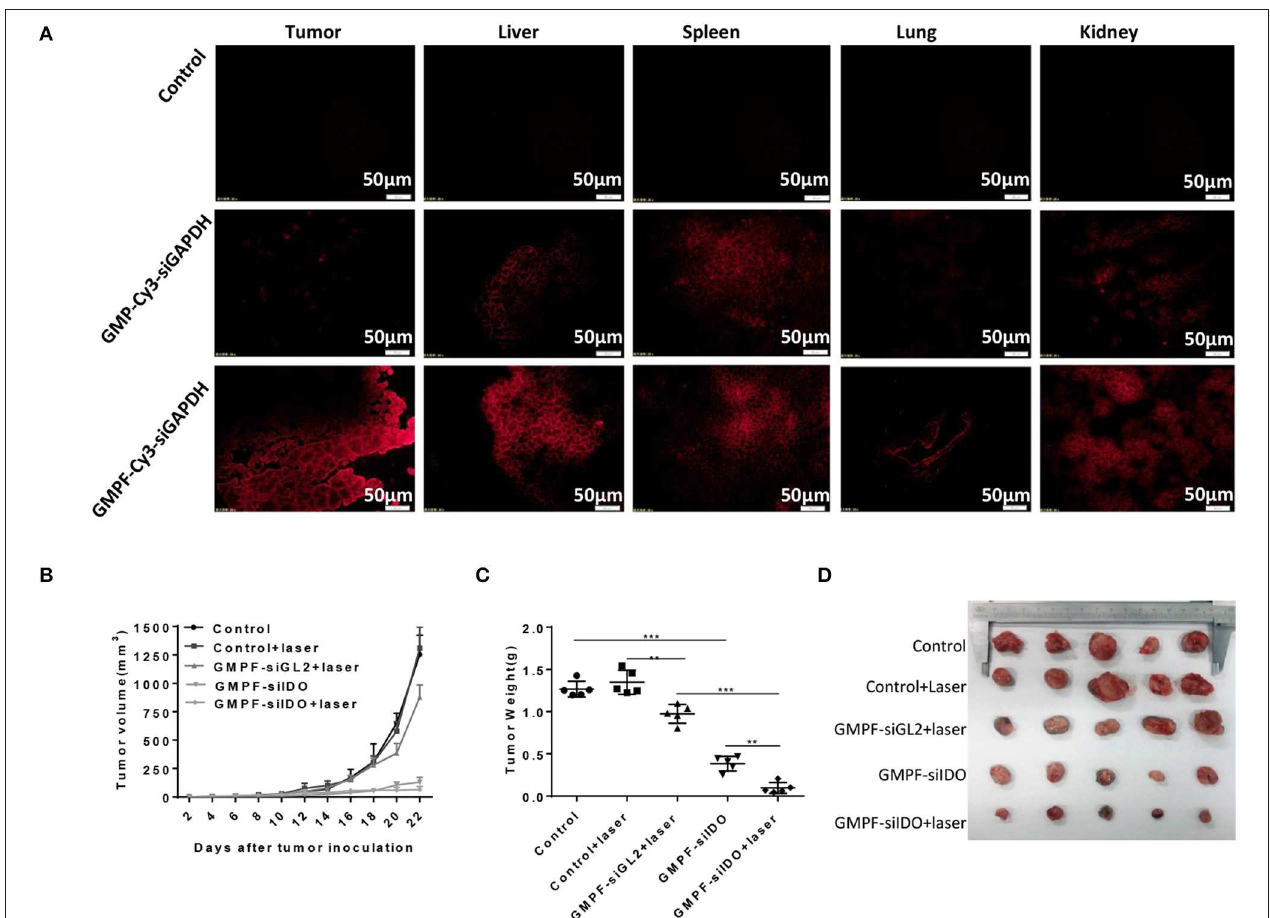
FIGURE 4 | Tumor-targeted photothermal-immunotherapy for lung cancer using multi-functionalized gold nanorods, GMPF-siIDO. (A) in vivo targeted delivery of GMFP-siGAPDH. LLC tumor bearing mice were intravenously injected with PBS (control), Cy3-labeled GMP-siGAPDH or GMFP-siGAPDH. 24h post administration, mice were sacrificed and the tumors, livers, spleens, lungs, and kidneys were isolated for frozen tissue sectioning. The fluorescent intensity of tissue sections was visualized using fluorescence microscopy. The data represents one of three independent experiments (Scale bar = 50 µ m). (B–D) Anti-tumor effects of GMPF-siIDO. LLC lung cancer bearing mice were intravenously injected with PBS (control), GMPF-siGL2 or GMPF-siIDO on day 4, 9, 14, and 19 after tumor inoculation. 24h after each treatment, the mice were irradiated by the 808nm near-infrared laser at 1 W/cm 2 for 5min. The tumor sizes were measured for 22 days after tumor inoculation (B) . At the end point of observation, the mice were sacrificed, and tumors collected. The tumor weights were measured (C) and the images of tumors are displayed in (D) . Error bars represent the standard deviation of three experiments (** P < 0.01; *** P <